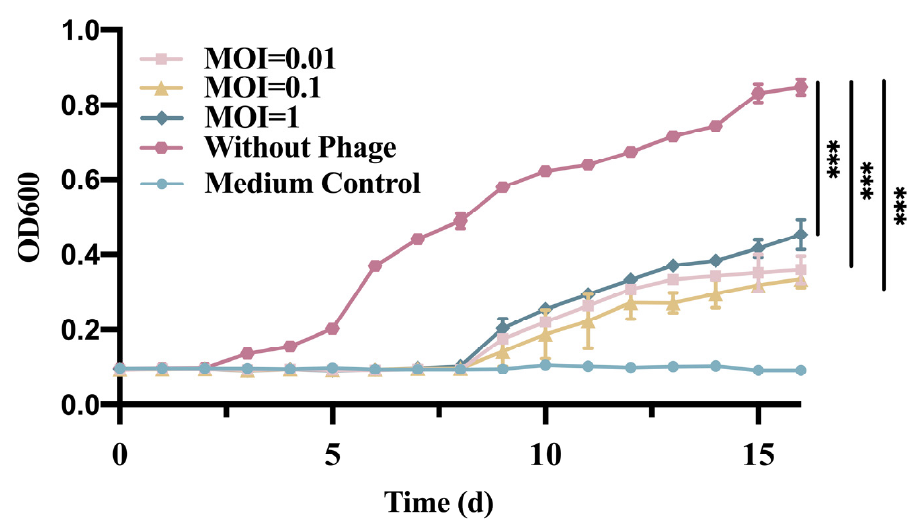
Figure 2. Effect of phage vB_EcoS_GN06 treatments on the growth of E. coli GXEC ‐ N22 at different MOI in MH broth (***: p < 0.001).